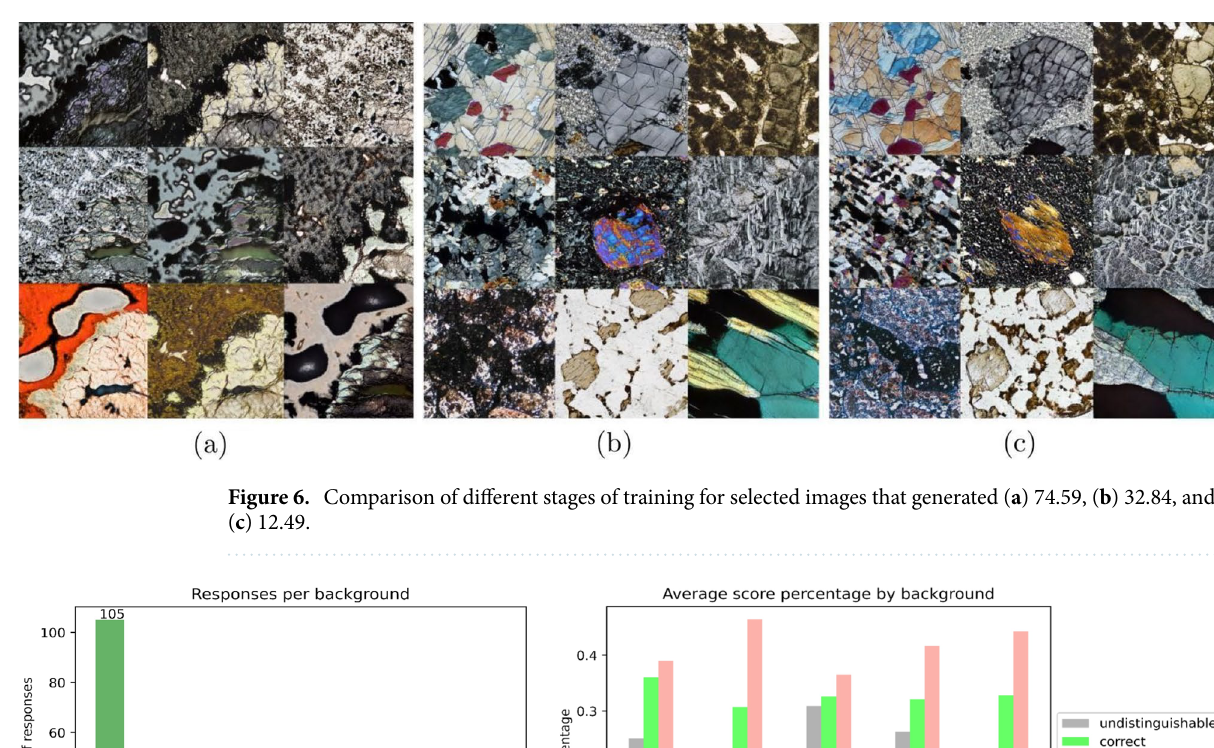
Figure 7. ( a ) Academic or industry experience for individuals with a geoscience related background and ( b ) results of the experiments, with average results by